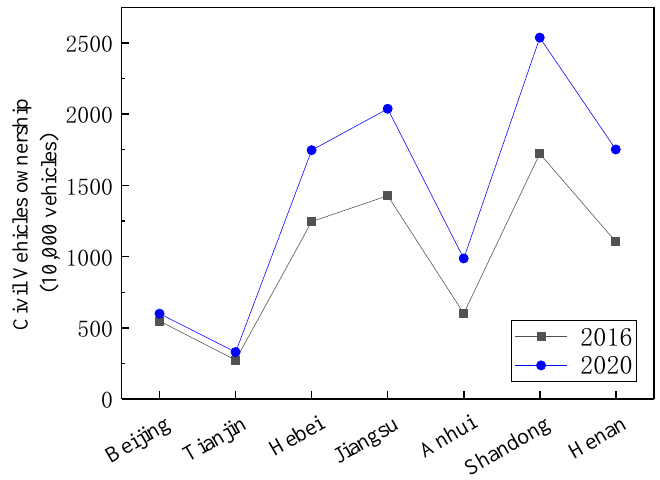
Figure 10. Changes in Civil Vehicle Ownership from 2016 to 2020.